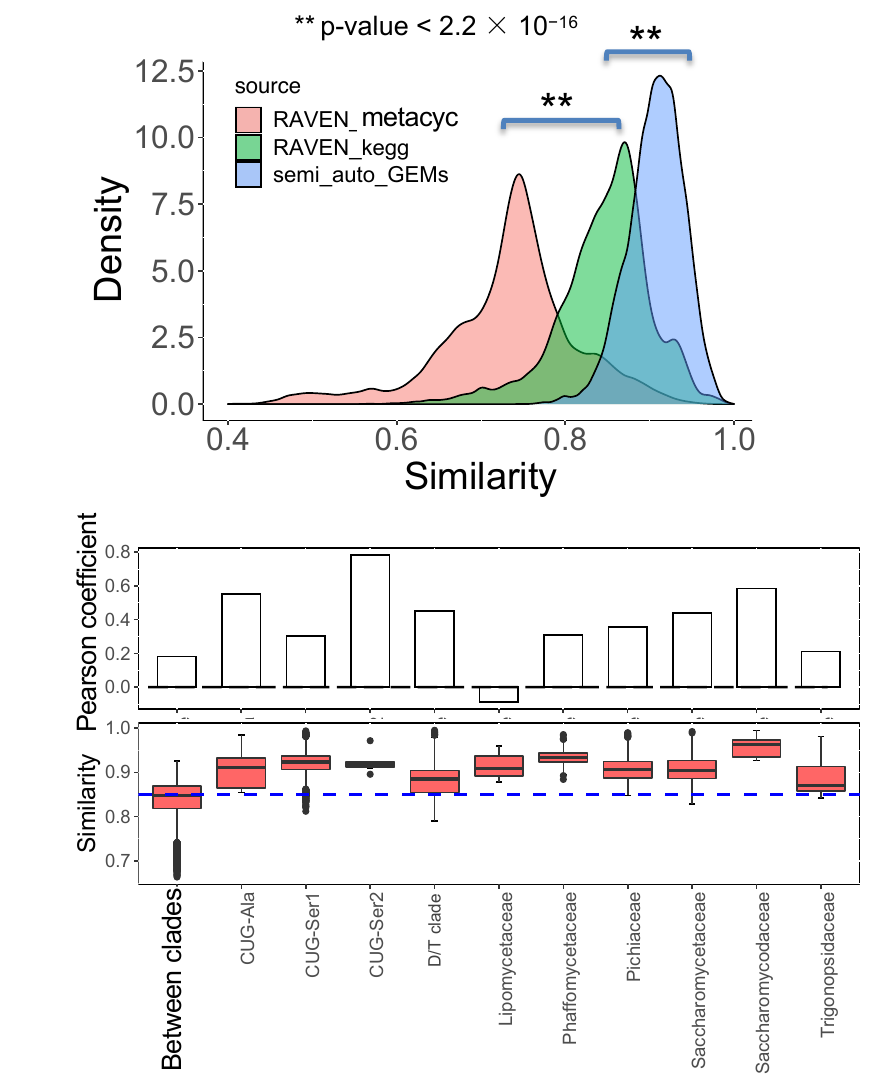
Figure 7. Similarity comparison for metabolic models from different procedures: ( a ) Models from the RAVEN toolbox are more dissimilar from each other than that from semi-auto GEMs from a template model; ( b ) model similarity analysis of main clade level for 332 yeast species based on draft GEMs from the RAVEN “KEGG” procedure. The Pearson coefficient is calculated to represent the correlation between model similarity and trait